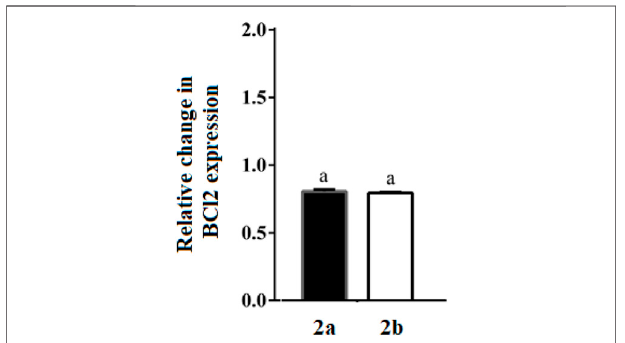
FIGURE 13 | Change in gene expression of Bcl2 in the treated HepG-2 cells. Different letters are signi fi cantly different at p < 0.05.